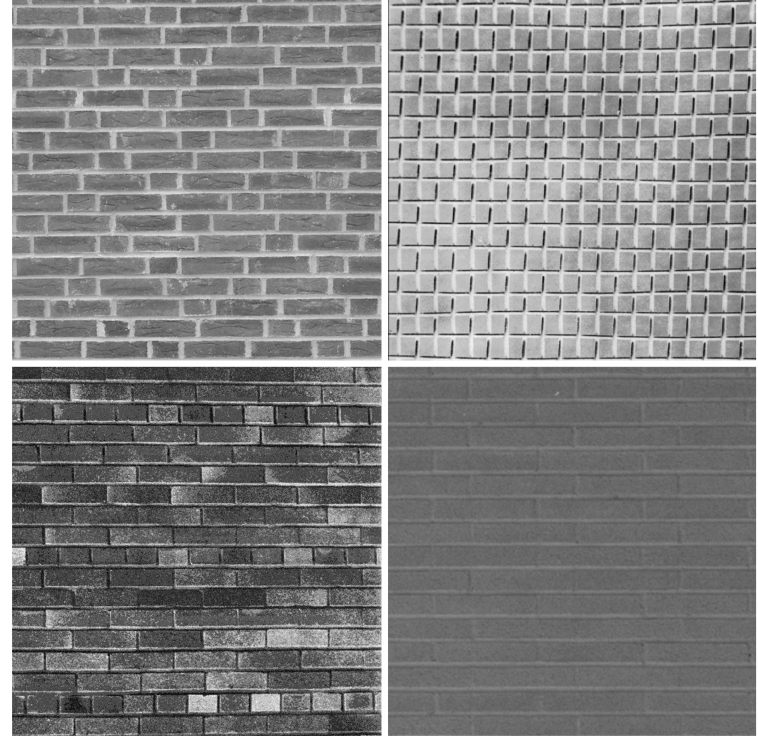
Figure 20. The set of textures for CSR measurements in Figure 18.